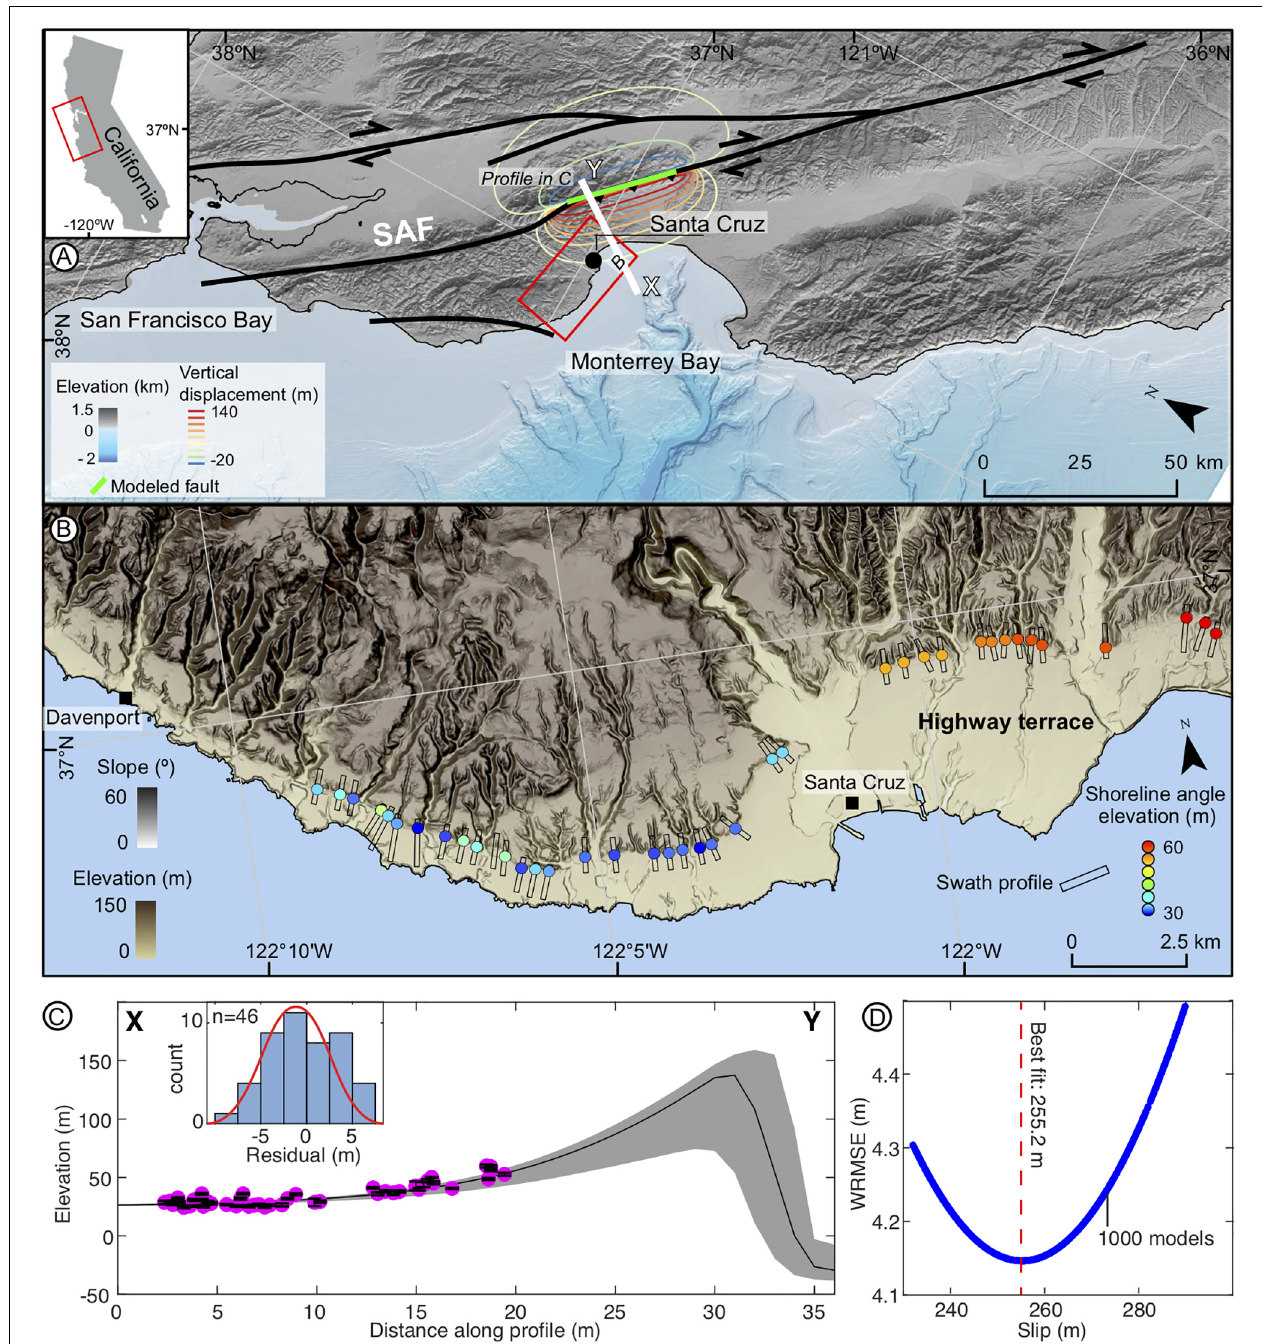
FIGURE 10 | Estimating fault-slip rate in Monterrey bay, California. (A) Tectonic setting displaying the location of the San Andreas Fault (SAF) and the Monterrey Bay. The green line is the rupture zone of the Mw 6.9 Loma Prieta earthquake, the white line X-Y is the profile in C , contours are the surface displacements of the best-fit dislocation model in C . (B) Shoreline angles mapped with TerraceM MAP colored by elevation. (C) Best fit elastic dislocation model, pink dots are shoreline angles, the inset display the distribution of residuals. (D) Iterations and Minimum weighted root mean squared error (WRMSE), red dashed line indicate the best-fit slip value.